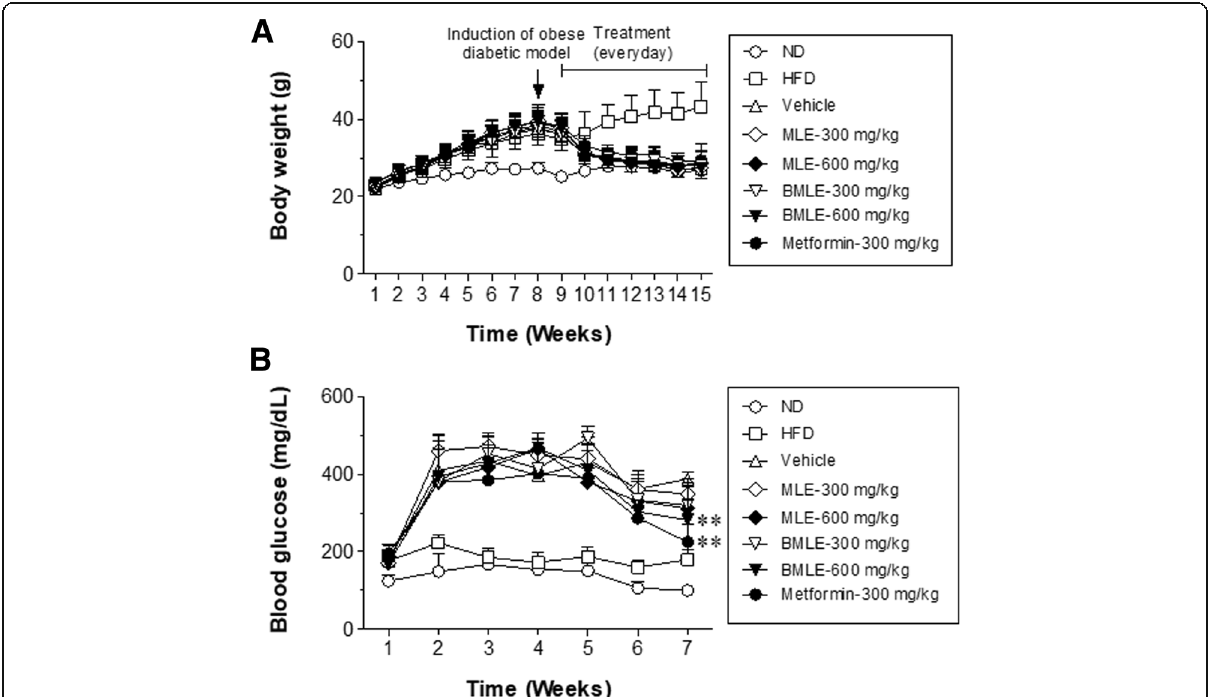
Fig. 4 Effects of bioconverted mulberry leaf extract (BMLE) compared to unaltered mulberry leaf extract (MLE) on the body weight and blood glucose levels of obese diabetic mice. Obese diabetic mice were produced by feeding on high-fat diet (HFD) for 8 weeks into six-week-old C57BL/6 mice and then (at the beginning of 9th week) injecting streptozotocin with nicotinamide (see Materials and methods). After checking for high blood glucose, mice were orally administered with MLE (300 and 600 mg/kg) or BMLE (300 and 600 mg/kg) for 7 weeks and the changes in ( a ) body weight and ( b ) blood glucose level were examined. Metformin (300 mg/kg) was used as a positive control. Data are expressed as the mean ± SEM ( n = 7). ** P < 0.01 versus blood glucose levels in vehicle-control